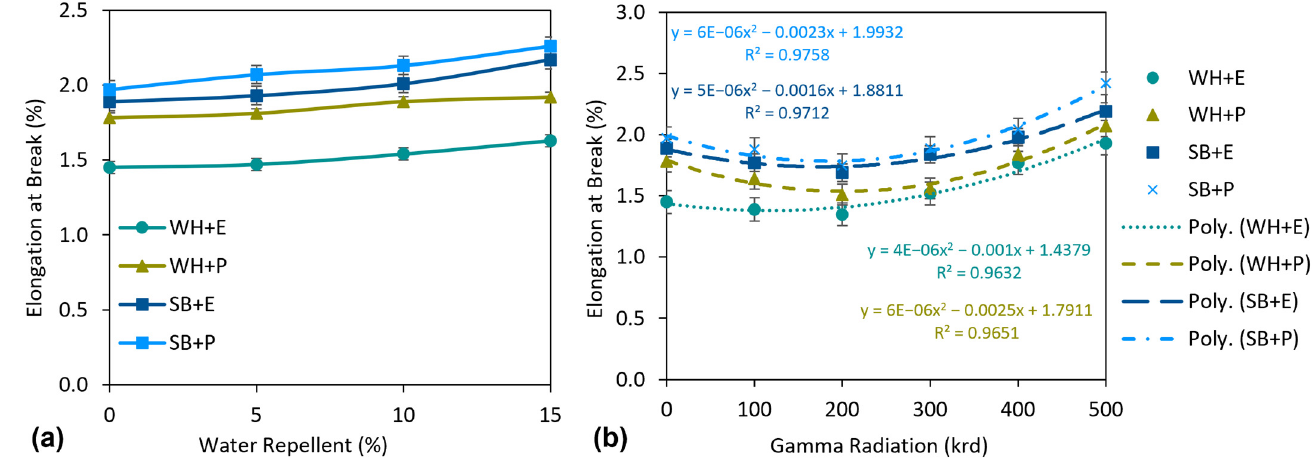
Figure 10. ( a ) Effect of water-repellent treatment and ( b ) effect of gamma radiation on elongation at break (%) of the composites. break (%) of the